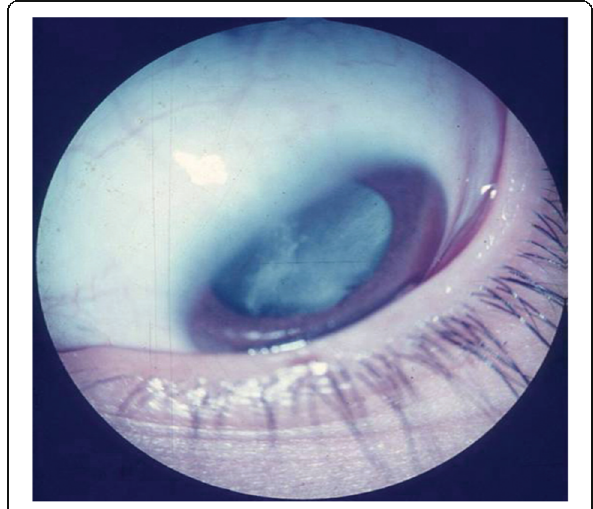
Fig. 3 Chronic toxocara endophthalmitis with partial retinal detachment (Cortez et al. 2011)